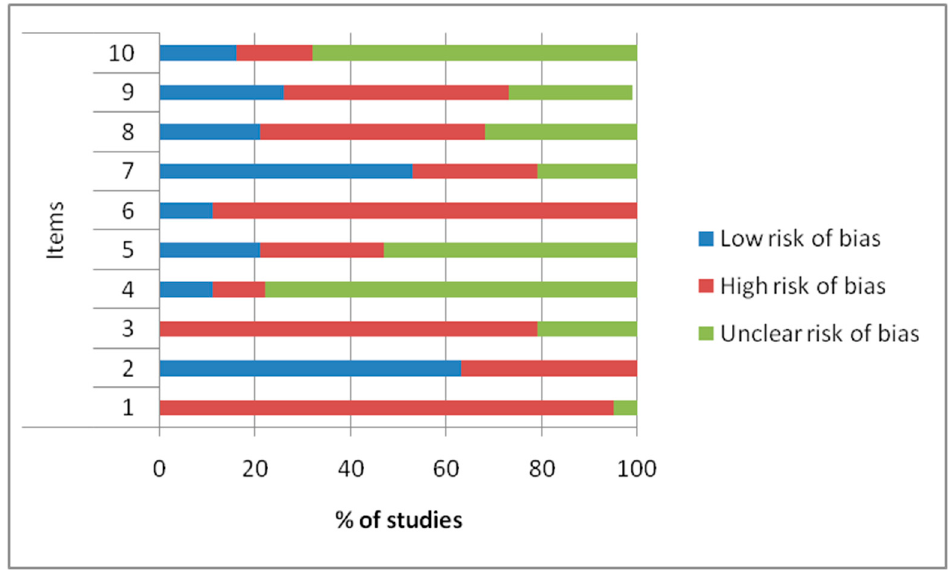
Figure 3. Frequencies (%) of risk of bias assessment according to Systematic Review Centre for Laboratory animal Experimentation (SYRCLE) tool.